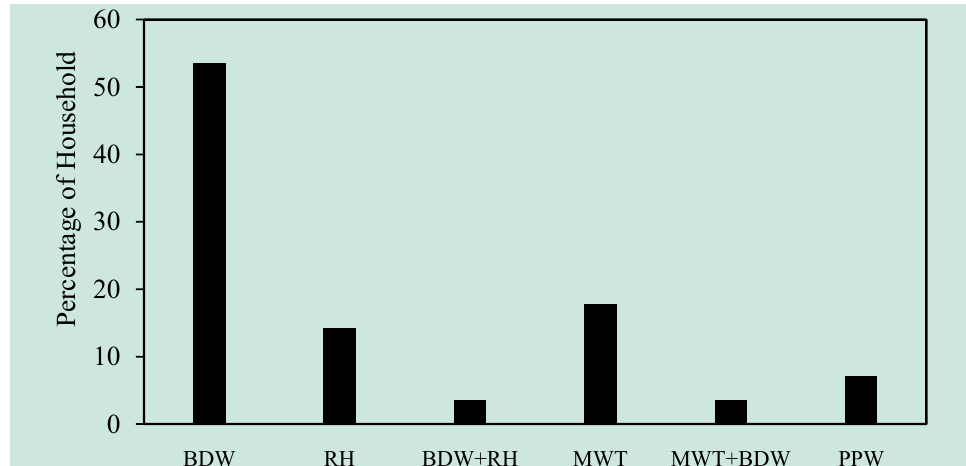
Figure 2. Existing Water Supply Systems in the Yokoè